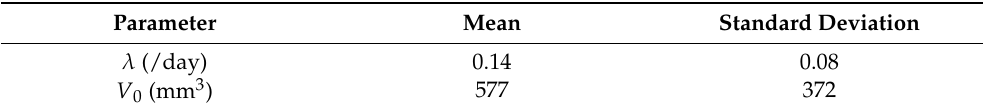
Table 1. Results of the regression analysis for tumor growth data in control mice up to 10 days with the number of data points ( n = 6).